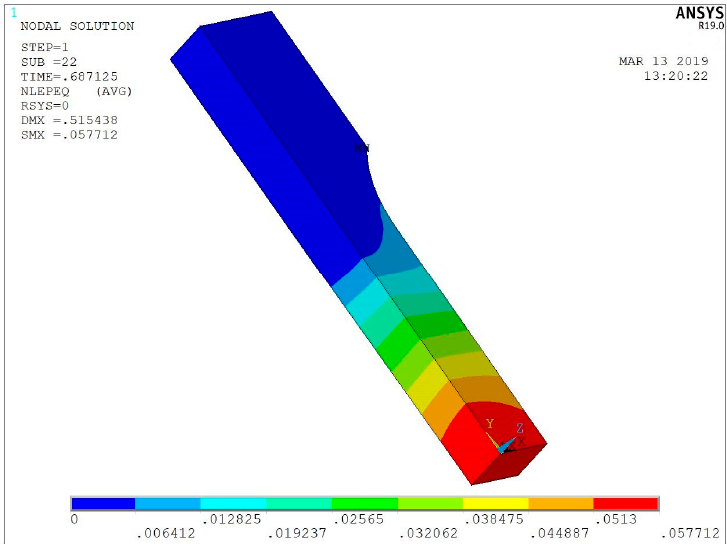
Figure 14. Total equivalent plastic strain distribution in the specimen at the time of fracture.